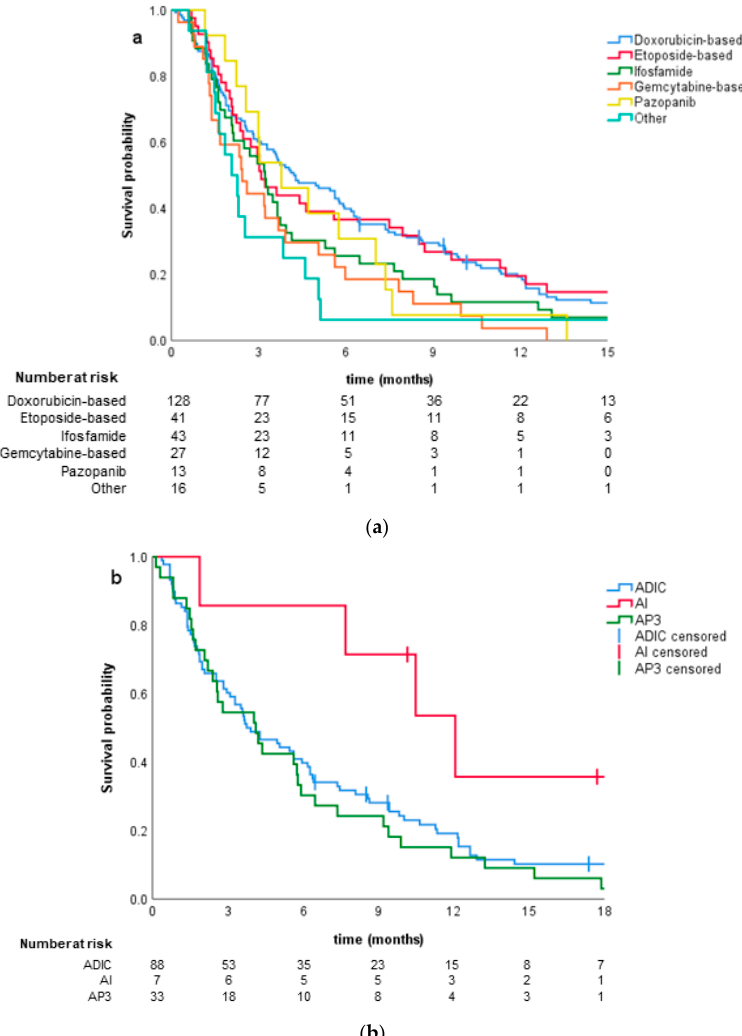
Figure 2. Comparison of progression-free survival: for all systemic therapy groups irrespective of the line of treatment ( a ); and for various doxorubicin-based regimens ( b ). ADIC, doxorubicin + dacarbazine; AI, doxorubicin + ifosfamide; AP3, doxorubicin + cisplatin. Among doxorubicin-based regimens, doxorubicin with ifosfamide was associated with better PFS compared to combination with dacarbazine or cisplatin, 12.1 vs. 3.75 vs. 4.1 months ( p = 0.041)